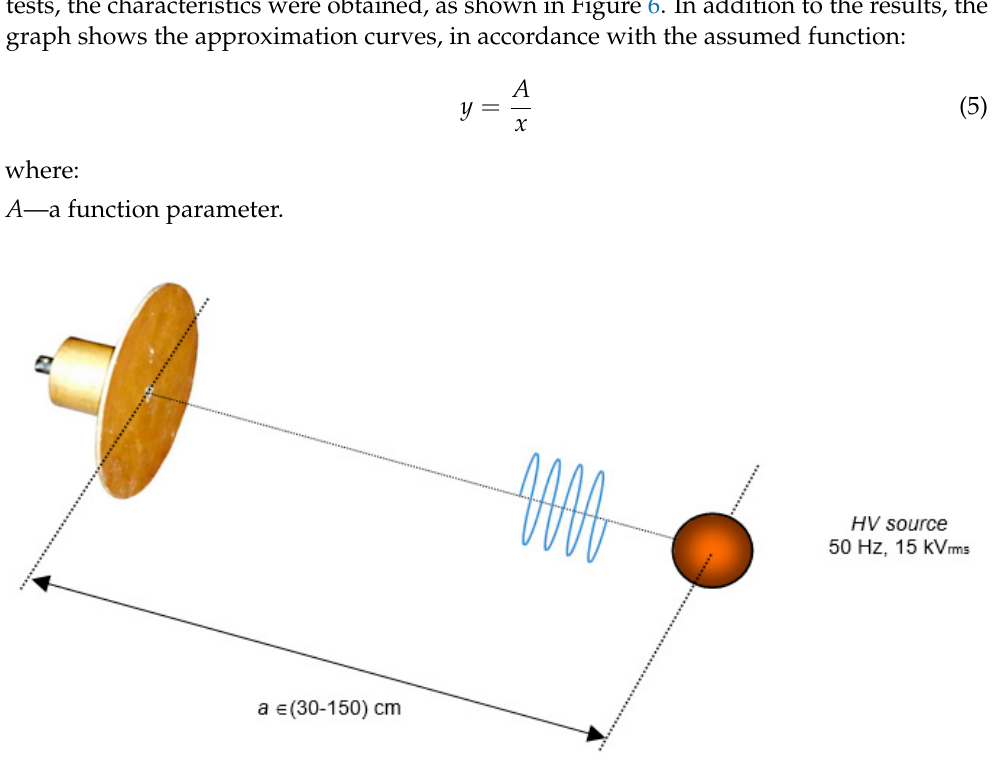
Figure 5. The method of determining the dependence of the amplitude of the signal registered by the sensor on the distance from the signal source.